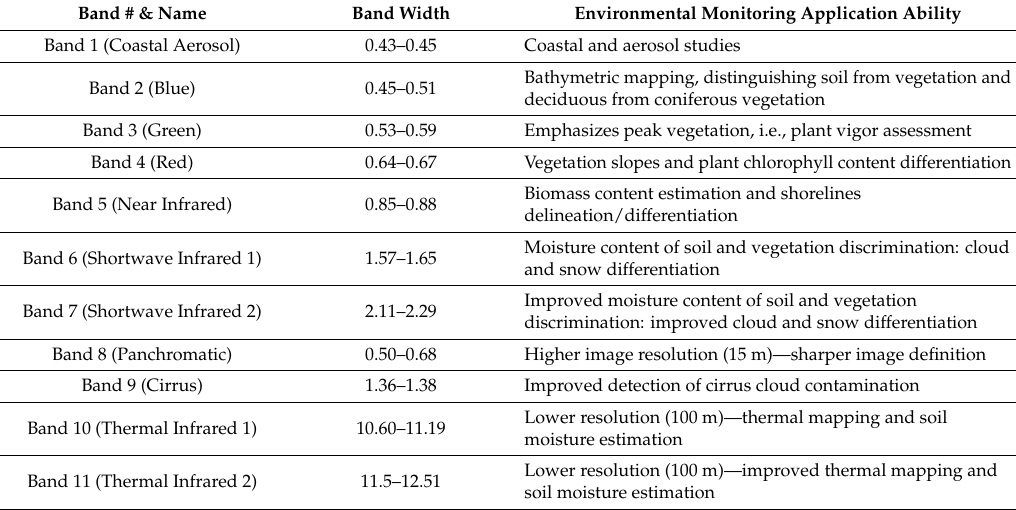
Table 2. Landsat 8 band information and its applications (adopted from http://landsat.usgs.gov/best_